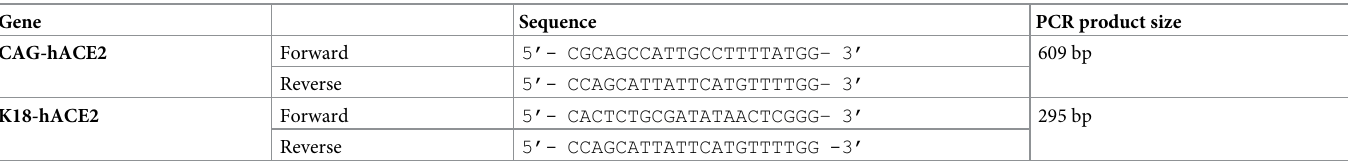
Table 1. PCR primers for identifying hACE2 transgenic mouse.